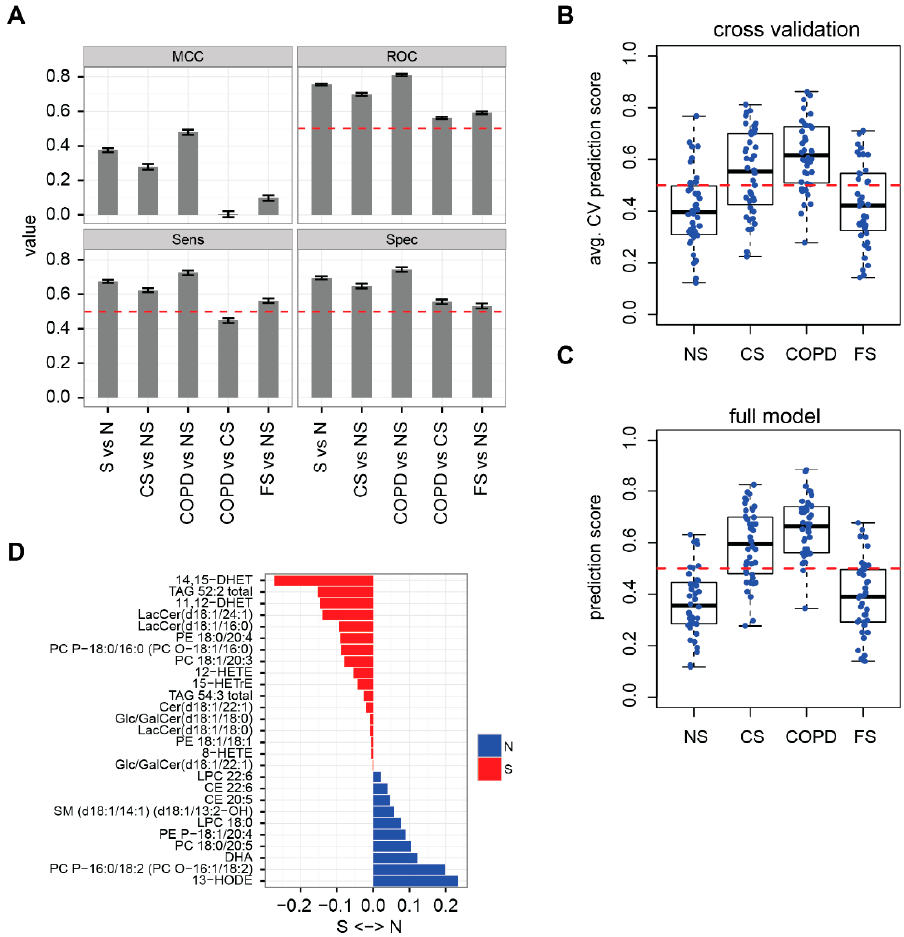
Figure 2. Lipidomics data allow for classification of the study groups. ( A ) Performance characteristics of elastic net logistic regressions for five classification tasks: all smokers (S) vs. all non-smokers (N), CS vs. NS, COPD vs. NS, COPD vs. CS, and FS vs. NS. The classifier was assessed by repeated ( n = 100) three-fold cross-validation and four performance metrics are shown (mean ± SEM): Matthew’s correlation coefficient (MCC), area under the receiver operator curve (ROC), sensitivity (Sens), and specificity (Spec); ( B ) average classification predictions of the S vs. N classifier for each individual sample of the four study groups. The cross-validation (CV) predictions for each sample were averaged over the repeats ( n = 100) and represented as a boxplot for each study group (black line = median). By default, a sample with a predicted score >0.5 (red, dashed line) was classified as a smoker (S), otherwise as a non-smoker (N); ( C ) final classification prediction scores for the full S vs. N model. Other details are as in Figure 2 B ; ( D ) lipids and their coefficients in the S vs. N classifier. An increase in lipids with a negative coefficient (red) tilted the classification of a sample toward smoker; an increase in lipids with a positive coefficient (blue) tilted the classification of a sample toward non-smoker. See abbreviations section for lipid nomenclature.